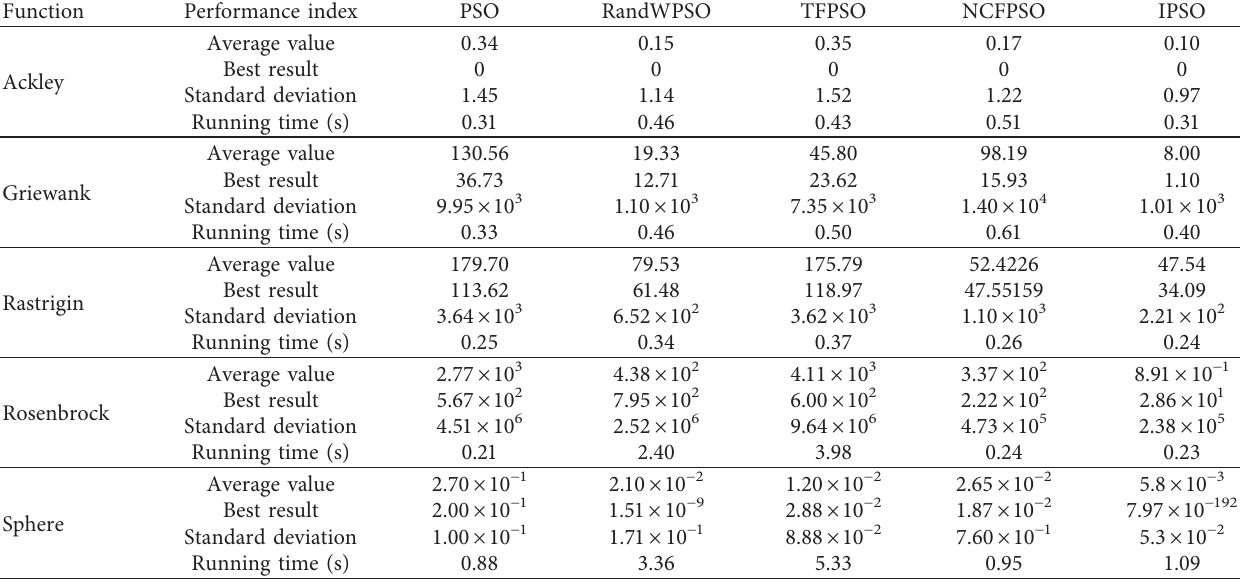
Table 2: Optimization results of five functions.